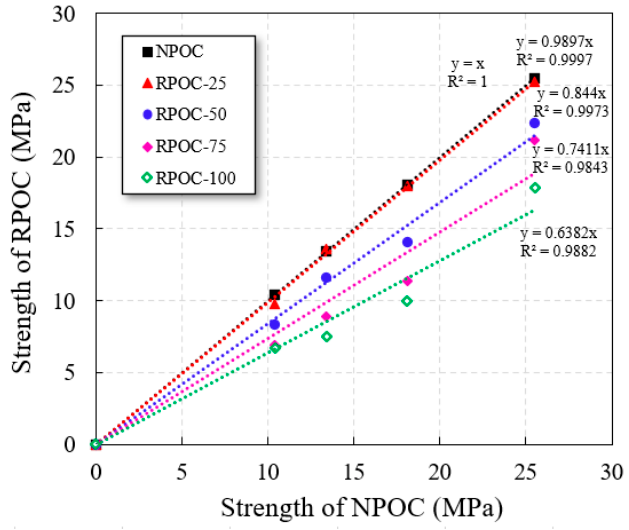
Figure 10. Relationship between compressive strength of porous concrete with a different replacement rate of RA.